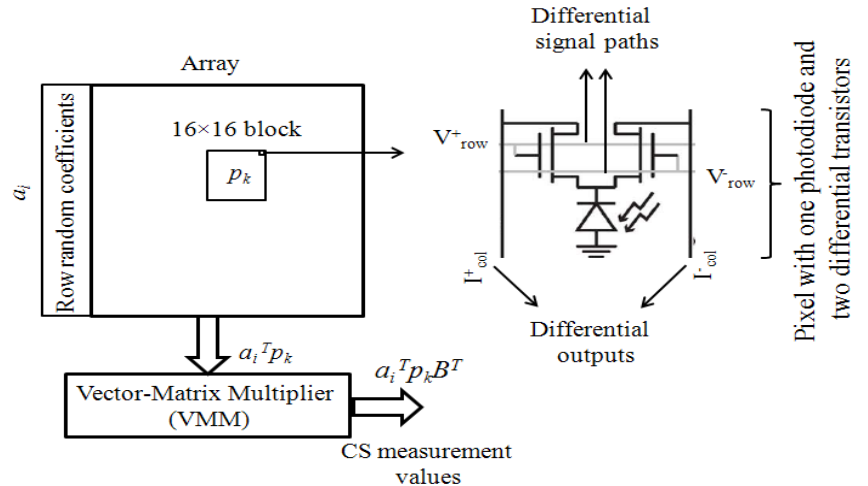
Figure 6. General schematic representation of the separable - transform imager (adapted from